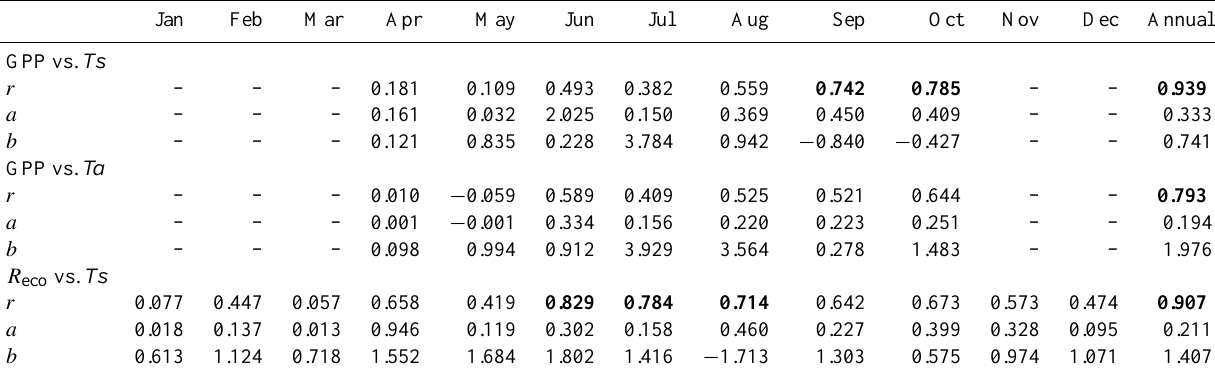
Table 4. Characteristics of linear regression analysis [ y = ax + b ] of daily mean ecosystem respiration ( R eco , in µmolm − 2 d − 1 ) and gross